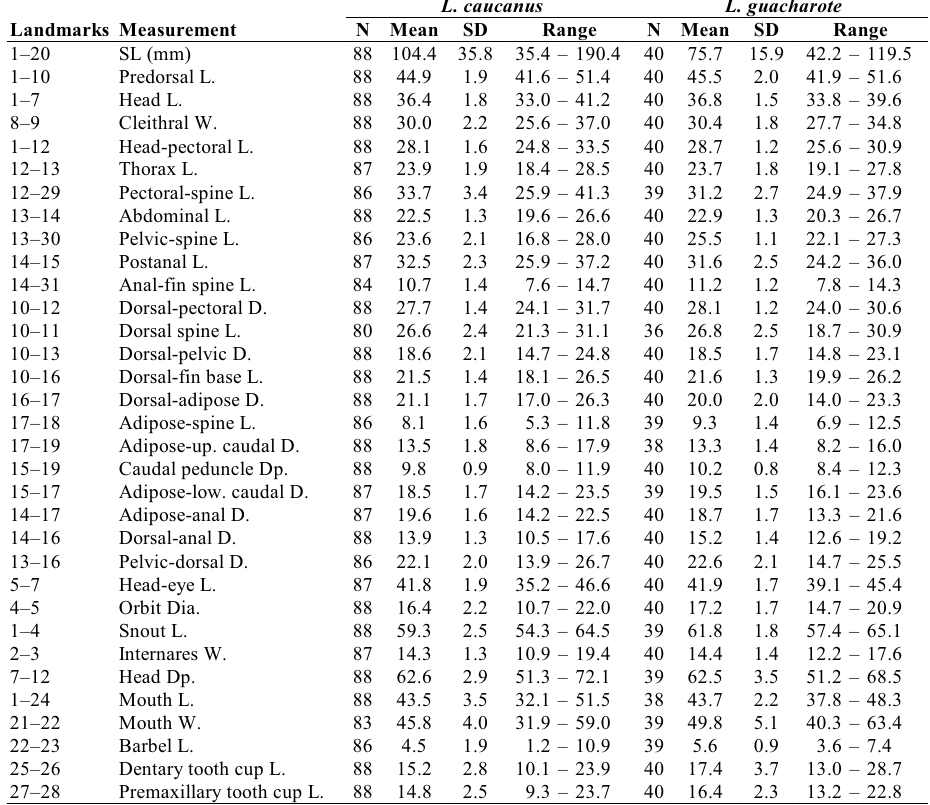
Table 1. Selected morphometrics of Lasiancistrus caucanus and L. guacharote . Ratios are percent of SL (Predorsal L. to Pelvic-dorsal D.) or percent of Head L. (Head-eye L. to Premaxillary tooth cup